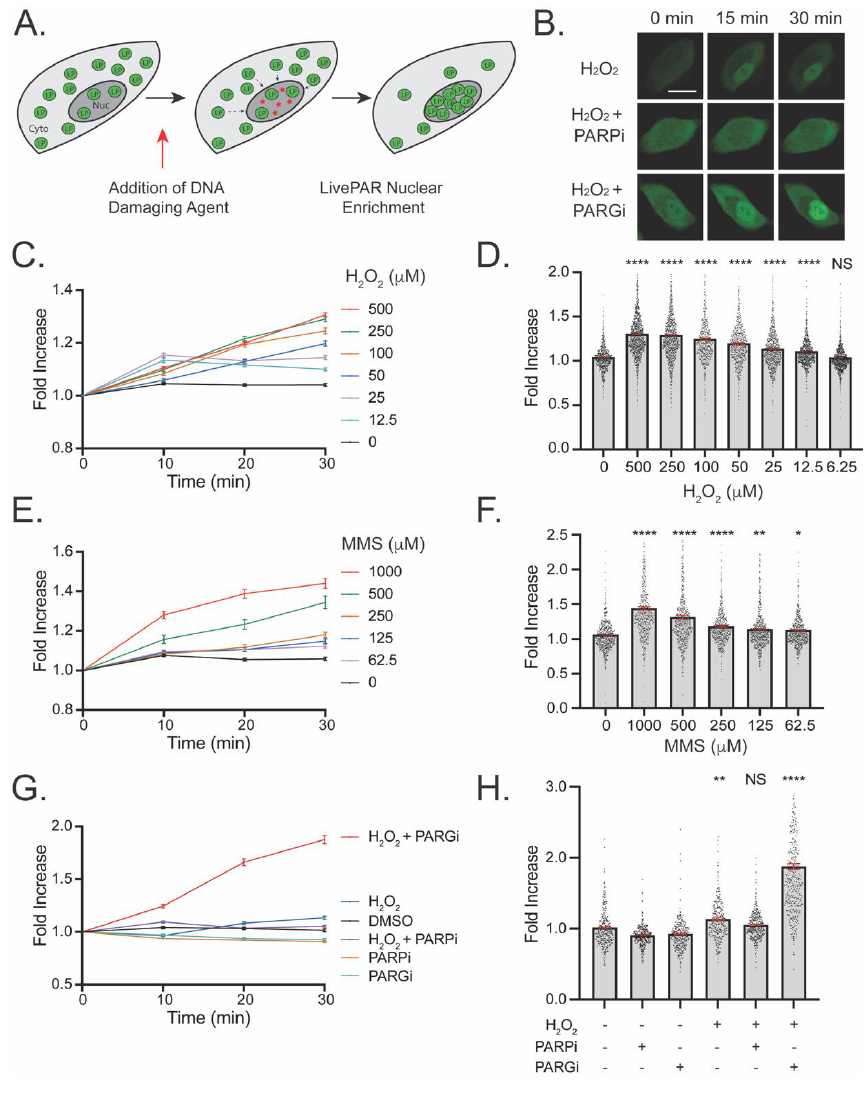
Figure 2. Detection of PARylation using LivePAR nuclear enrichment in live cells. ( A ) Diagram of mechanism: Prior to stress, LivePAR (green circles) is uniformly observed throughout a cell. H 2 O 2 generates DNA damage in the nucleus (red stars) and stimulates PAR formation and LivePAR nuclear enrichment. ( B ) LivePAR nuclear enrichment following H 2 O 2 (250 µ M) exposure. PARPi (ABT-888; 10 µ M) prevented LivePAR nuclear enrichment, while PARGi (PDD00017273; 10 µ M) enhanced LivePAR nuclear enrichment. White scale bar denotes 20 µ m. ( C ) Time course of LivePAR nuclear enrichment fol- lowing H 2 O 2 dose–response over 30 min. Graph shows mean ± SEM. ( D ) LivePAR nuclear enrichment 30 min following H 2 O 2 dose–response. Each point represents a single cell nucleus. Graph shows mean ± SEM (in red). ( E ) Time course of LivePAR nuclear enrichment following MMS dose–response. Graph shows mean ± SEM. ( F ) LivePAR nuclear enrichment 30 min following MMS dose–response. Each point represents a single cell nucleus. Graph shows mean ± SEM (in red). ( G ) Time course of LivePAR nuclear enrichment following H 2 O 2 (250 µ M) treatment, with and without PARPi or PARGi. Graph shows mean ± SEM. ( H ) LivePAR nuclear enrichment 30 min following H 2 O 2 (250 µ M) treatment, with and without PARPi or PARGi. Each point represents a single cell nucleus. Graph shows mean ± SEM (in red). NS = no significance, * p < 0.05, ** p < 0.01, **** p < 0.0001; a two-sample t-test (compared to the untreated controls) for panels D and F, and a one-way ANOVA with Tukey post-hoc test (significance compared to untreated controls) for panel H. For panels C-H, each data point represents the mean ± SEM for at least 100 individual